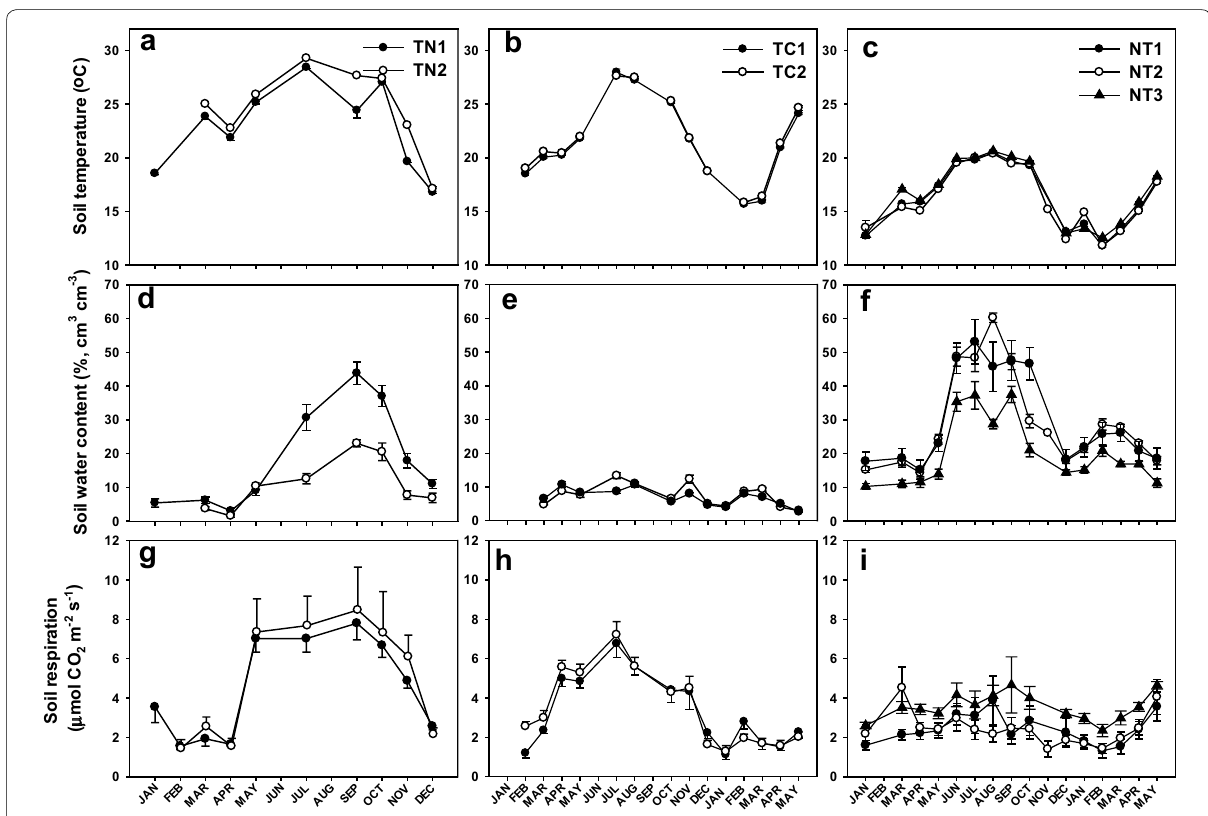
Fig. 2 Seasonal patterns of soil temperature (°C), soil water content (%, cm 3 cm − 3 ), and soil respiration rate (μmol CO 2 m − 2 s − 1 ) at TN ( a , d , g ), TC ( b , e , h ), and NT ( c , f , i ) plantations in Taiwan. Each symbol is the mean of the measurements, and the standard deviation is plotted as error